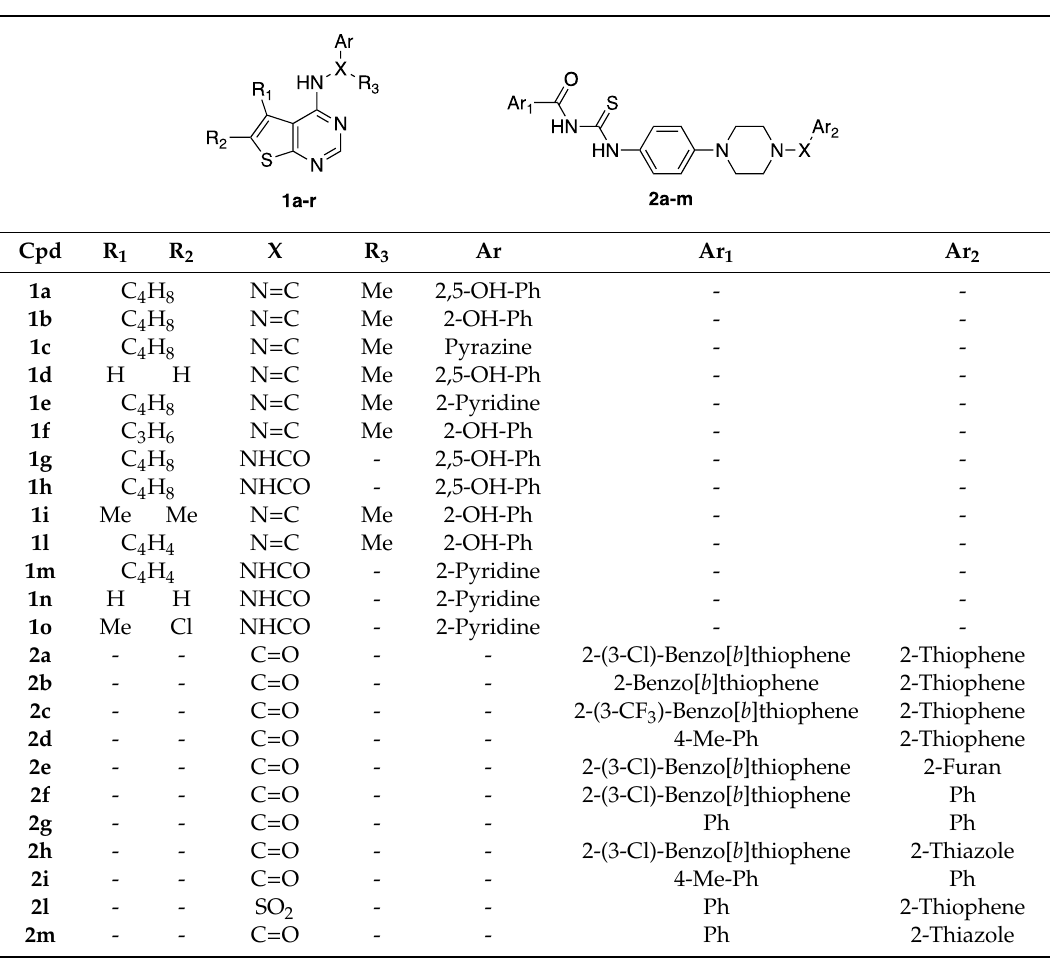
Table 1. Chemical structures of compounds 1a – 1o and 2a – 2m , previously reported non-nucleoside antiviral agents, selected for evaluation against ZIKV-induced cytopathic effect in relevant cellular models of the infection.